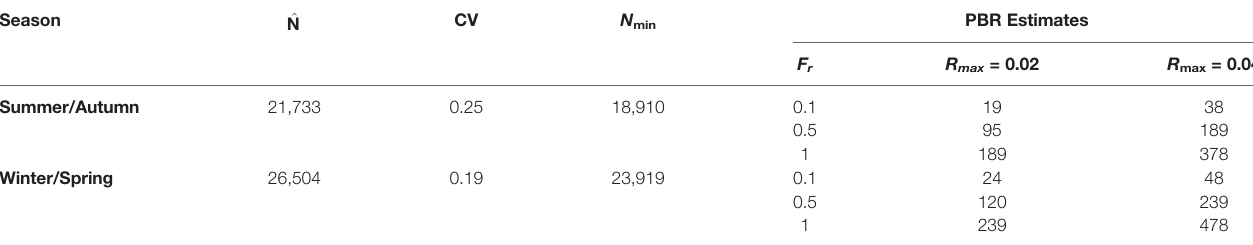
TABLE 4 | Estimates of abundance ( ^ N ) coef fi cient of variation (CV), 20 th Percentile of abundance ( N min ) and the maximum number of common dolphins ( Delphinus delphis ) that may be removed sustainably (Potential Biological Removal, PBR) from central South Australia under different recovery factors ( F r ) and maximum population growth rates ( R max